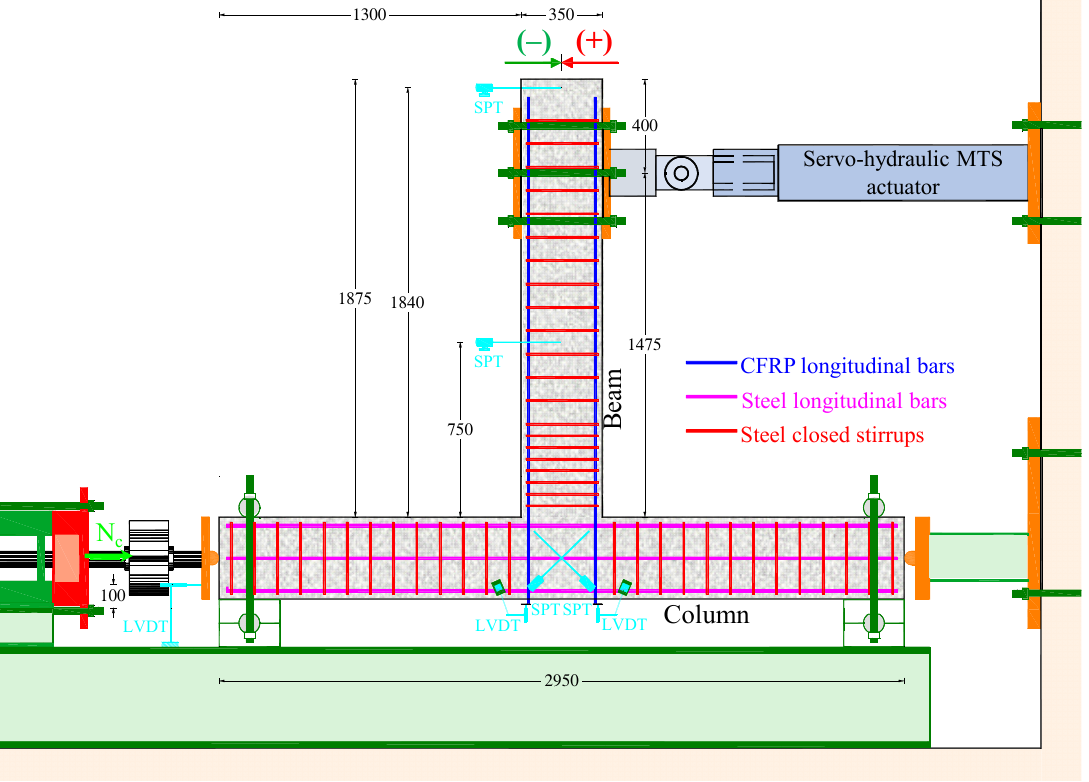
Figure 1. Schematic drawing of the test setup, geometry and reinforcement of the beam-column joint specimens subjected to cyclic reversal deformations (dimensions in mm).